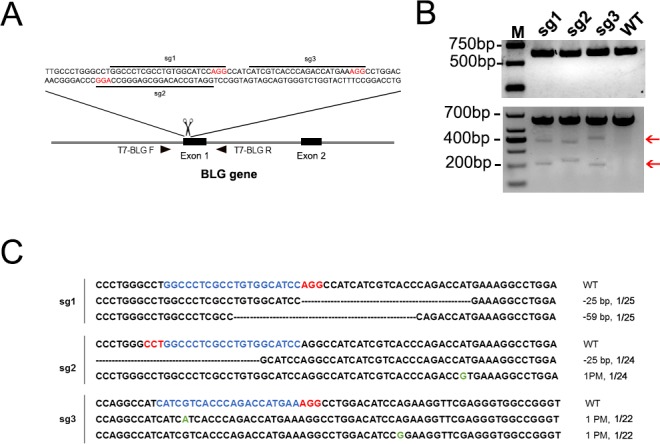
CRISPR/Cas9-mediated modification of the BLG locus in fibroblasts.(A) Schematic diagram of sgRNA design for the goat BLG locus. Primers labeled as “BLG-T7-F” and “BLG-T7-R” were used for the T7E1 cleavage assay at the sg1, sg2, and sg3 target sites. (B) Targeting BLG loci using single sgRNA by electroporation. Top panel: PCR products of the target region of BLG from fibroblasts transfected with a single Cas9-sgRNA plasmid. Bottom panel: T7E1 assay of products shown in the top panel. M, marker; WT, wild-type cells without treatment with Cas9 plasmid. Red arrows indicate the expected cleaved products after T7E1 cleavage assay. (C) Sequencing results of sgRNAs targeting BLG.